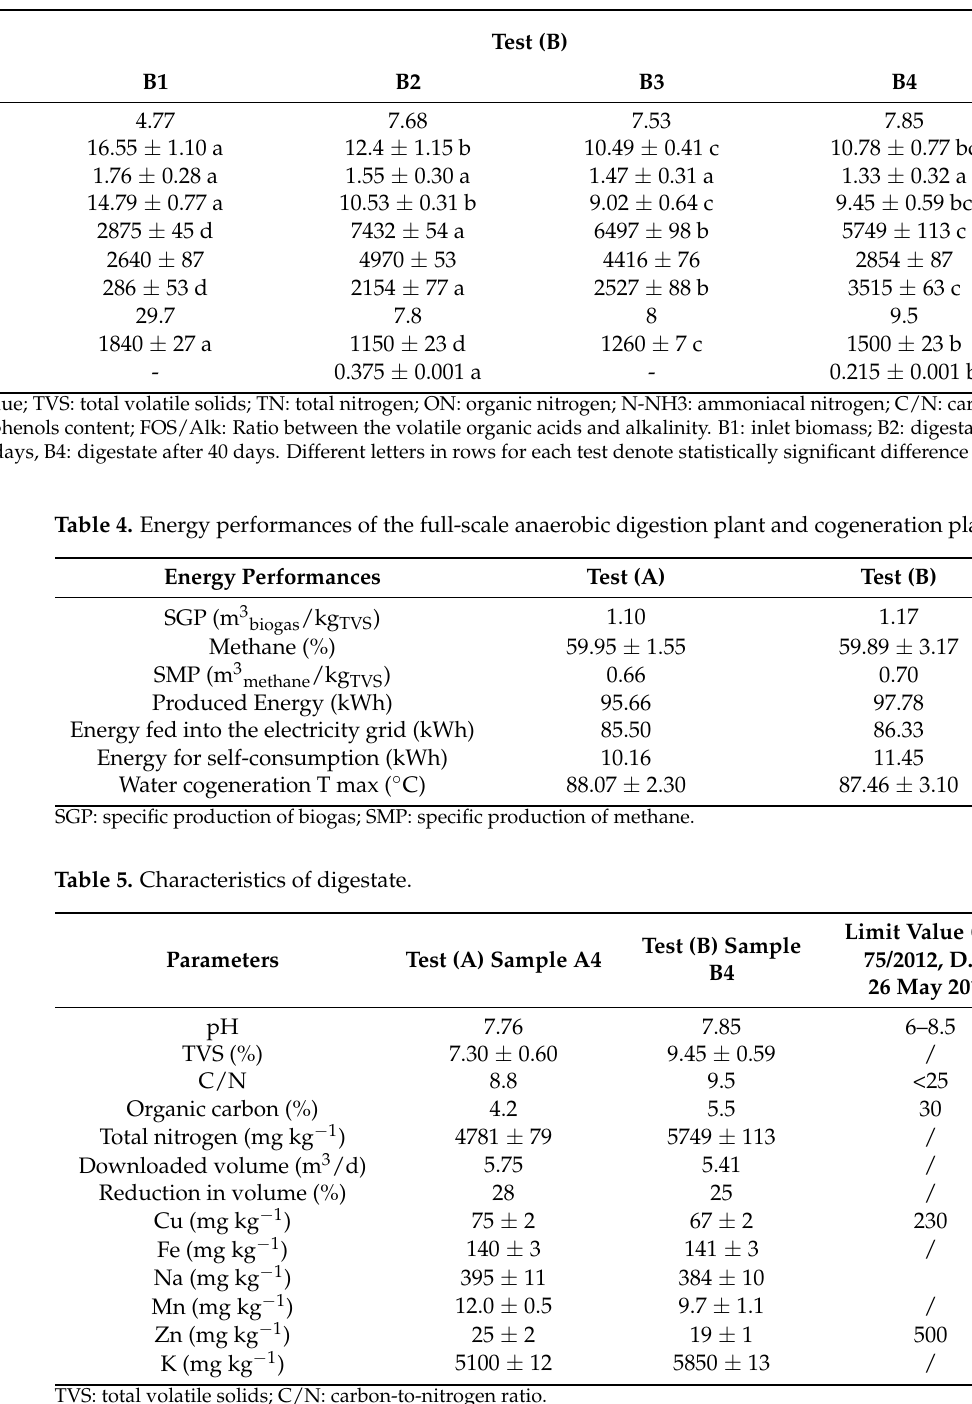
Table 3. Results of the chemical analyses of the evolving biomass of Test B.